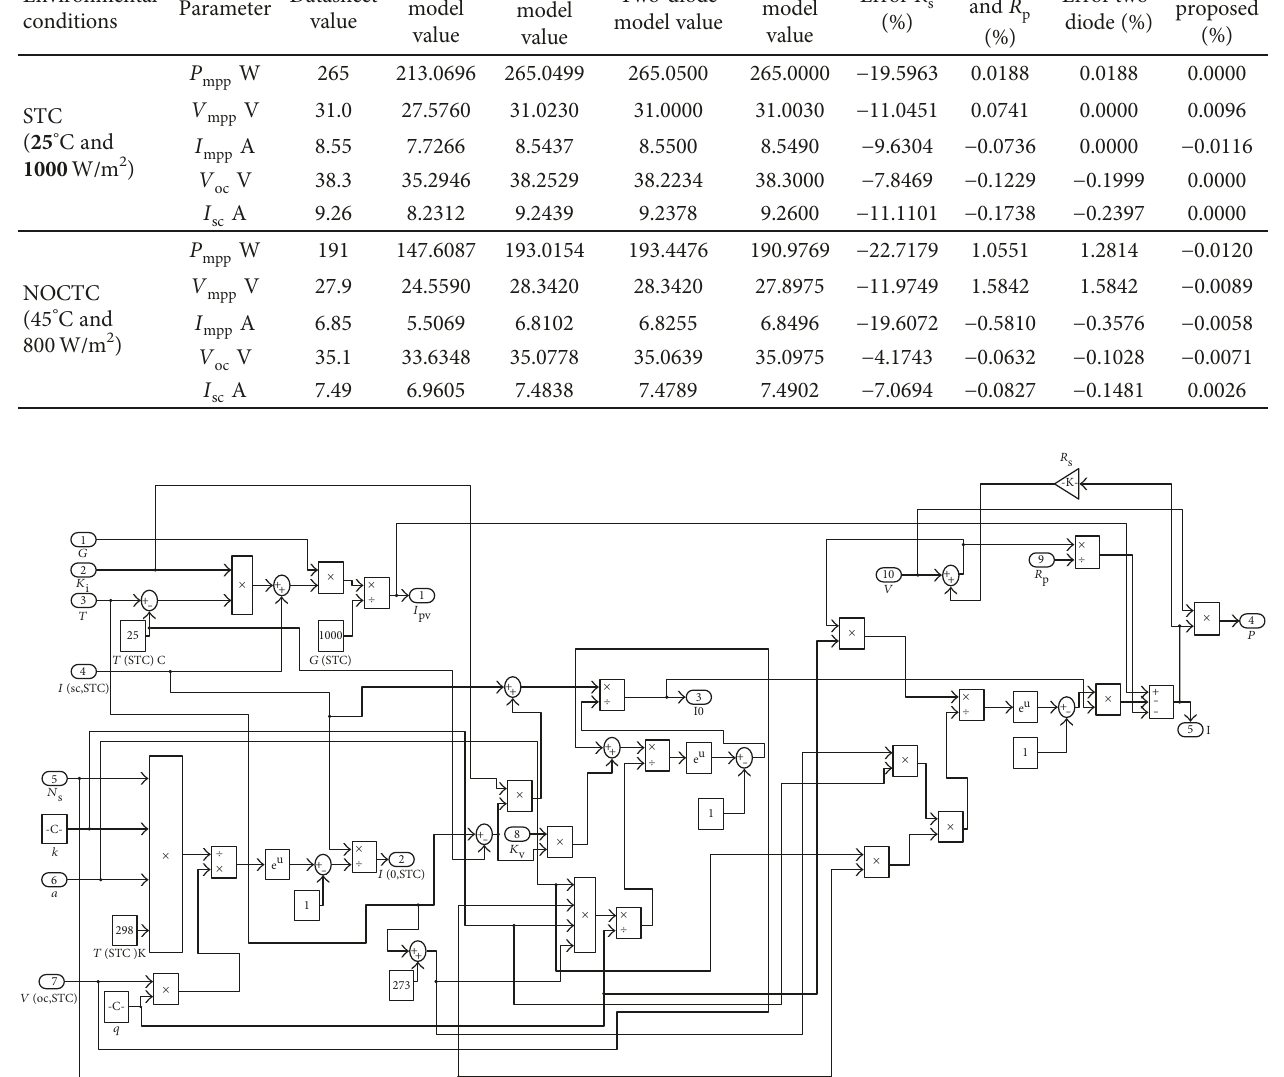
Figure 8: Detailed implementation of PV module model in MATLAB/Simulink that solves the I-V